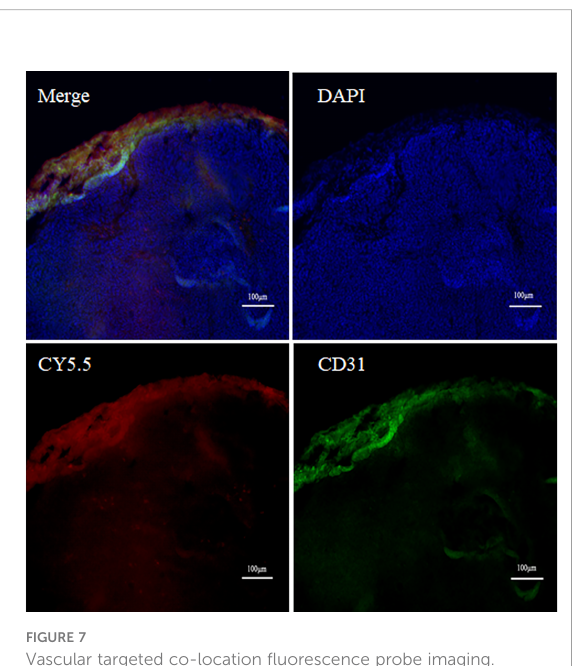
FIGURE 7 Vascular targeted co-location fl uorescence probe imaging. Double labeling fl uorescence using CD31 (green) and (GEBP11) 2 - Acp-Cy5.5 (red) probe showed tumor vessels in the peripheral area near the tumor